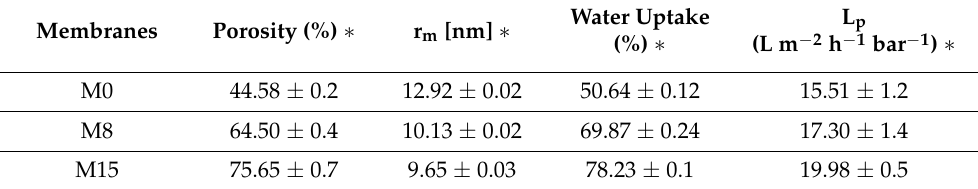
Table 4. Summary of the CA and CA/PAA blended membranes prepared.